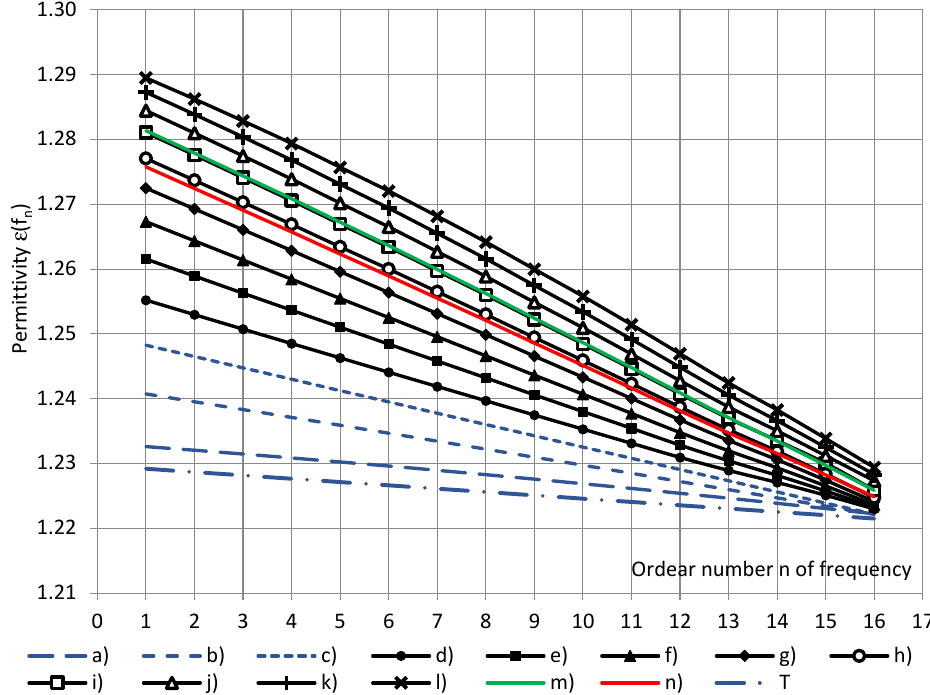
Figure 13. The calculated permittivity spectra of PU SikaBlock ® -M150 foams (density of 144 kg/m 3 ) at water vapor mass in air of the test room m w : (a–c) m w = 0.0, 1.0, and 2.0 g/m 3 (blue, extrapolated); (d–l) m w = 3.0, 4.0, …, 11.0 g/m 3 ; green—at the standard reference conditions m w = 8.05 g/m 3 , red—at the average m wav = 6.70 g/m 3 and “T”—the true permittivity spectrum (“n”—the ordeal number of